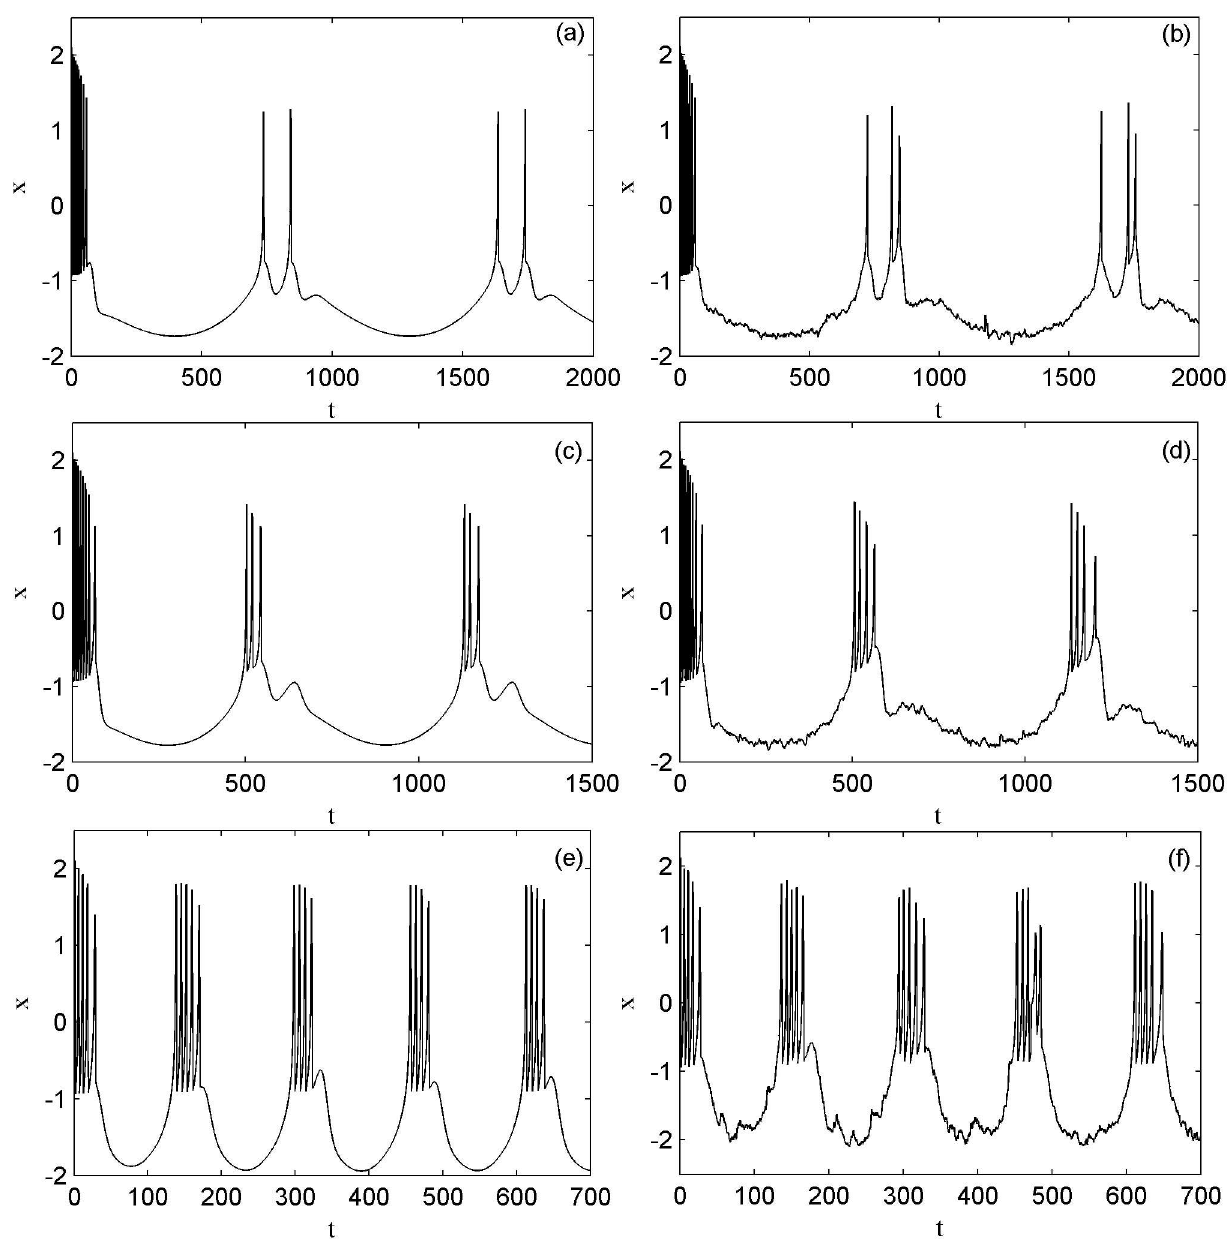
Fig 3. The time series of the membranepotential of neuron under different external radiation-induced magnet flux.